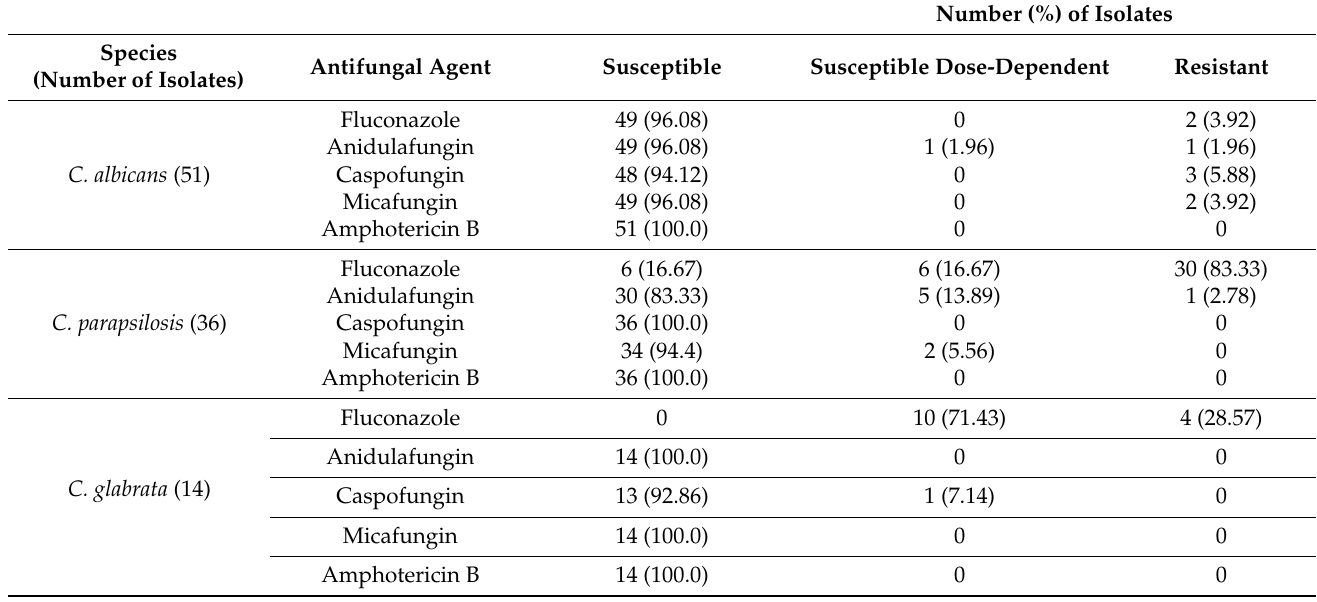
Table 5. Susceptibility to antifungal agents of the three most frequently isolated Candida spp. in the period